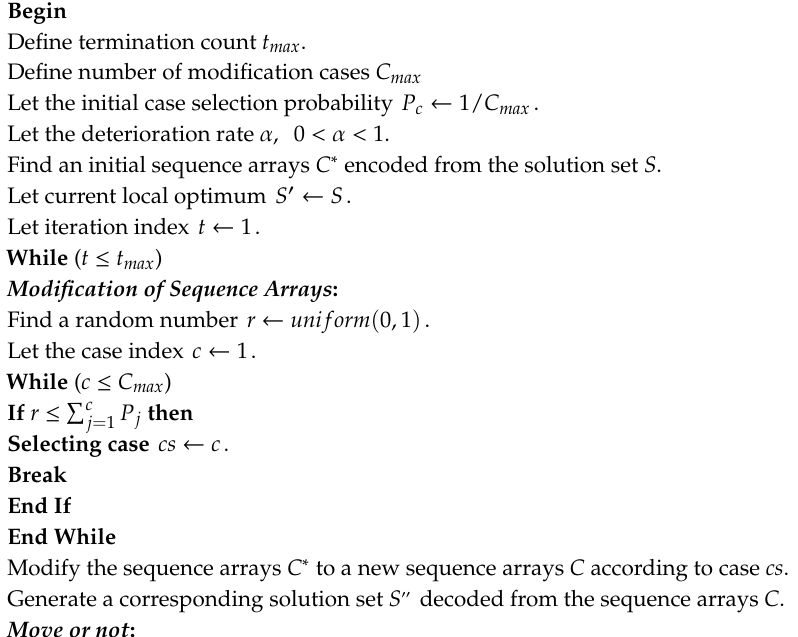
Algorithm 3. Local search with dynamic case selection